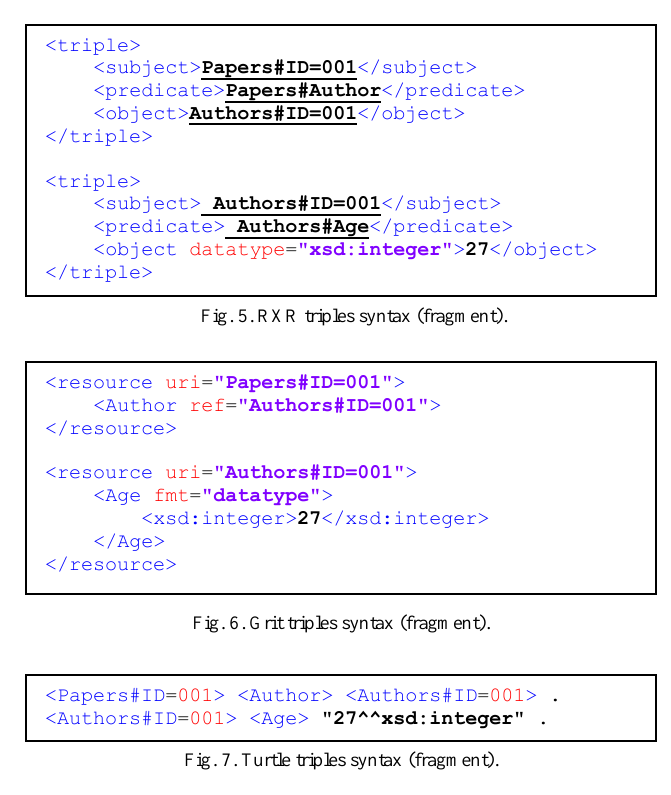
Fig. 7. Turtle triples syntax